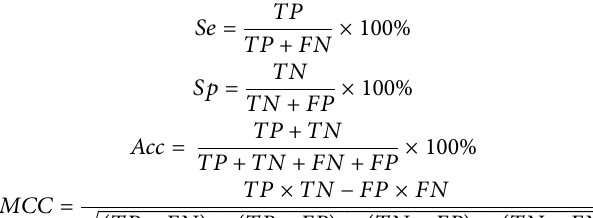
Ten-fold cross-validation